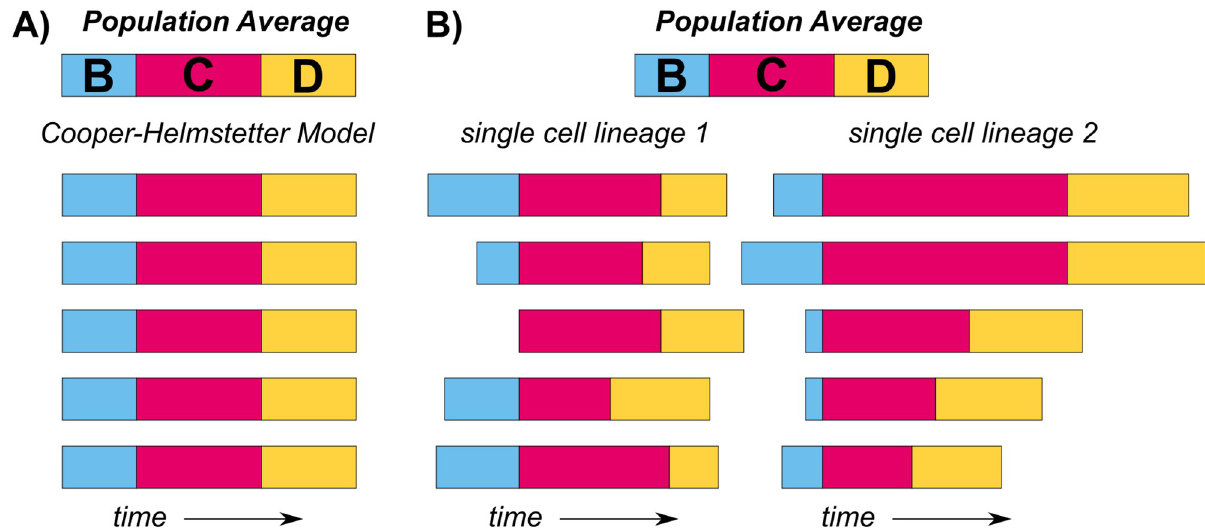
Fig 2. Deterministic paradigm vs. stochastic nature of cell cycle timescales. (A) The Cooper–Helmstetter model assumes that all cells within a given condition follow the population average B, C, and D periods. (B) Relative B, C, and D periods are shown over multiple consecutive replication cycles for 2 cell lineages grown on MOPS glucose (based on data from Si and colleagues). Significant differences between replication cycles necessitate a new theory accounting for stochasticity.